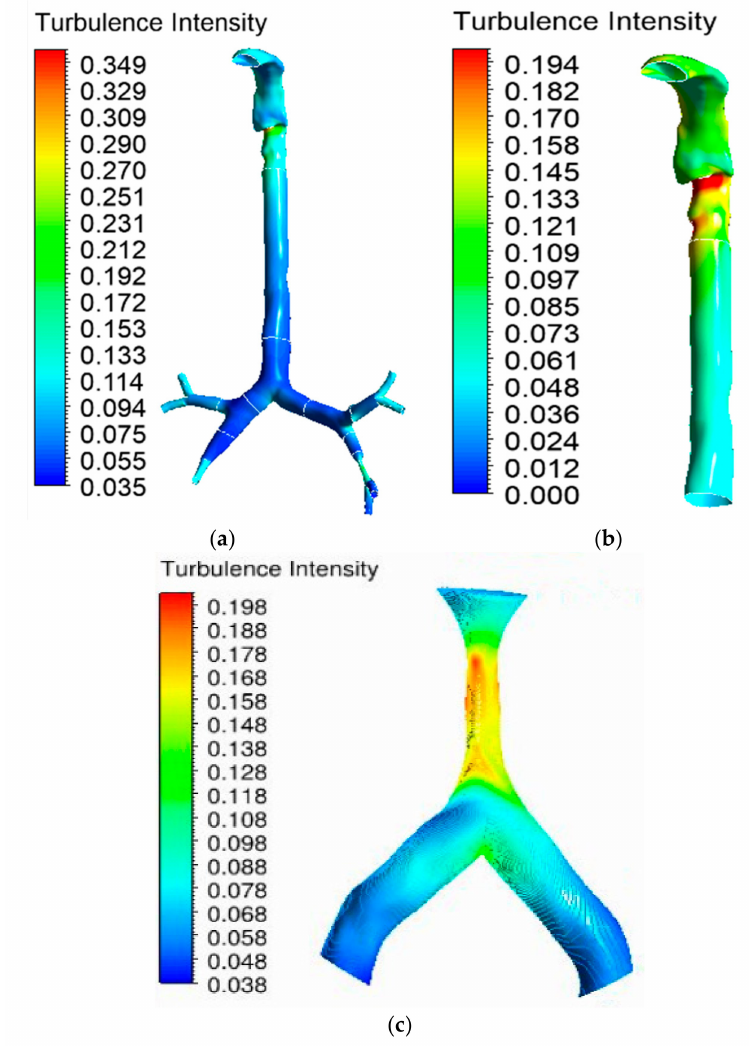
Figure 13. Turbulence intensity at 30 lpm for the right stenosis lung model: ( a ) whole model, ( b ) mouth–throat and trachea (intensity range rescaled), and ( c ) right lung stenosis